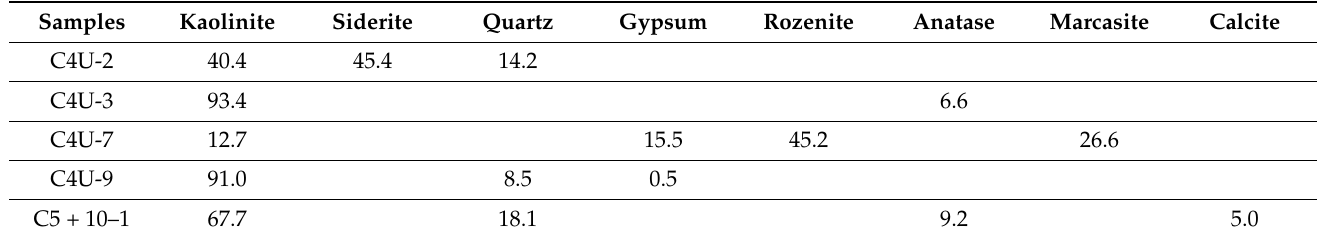
Table 3. Mineralogical compositions of raw coal and non-coal samples by XRD and MDI Jade 6.0 (wt%).